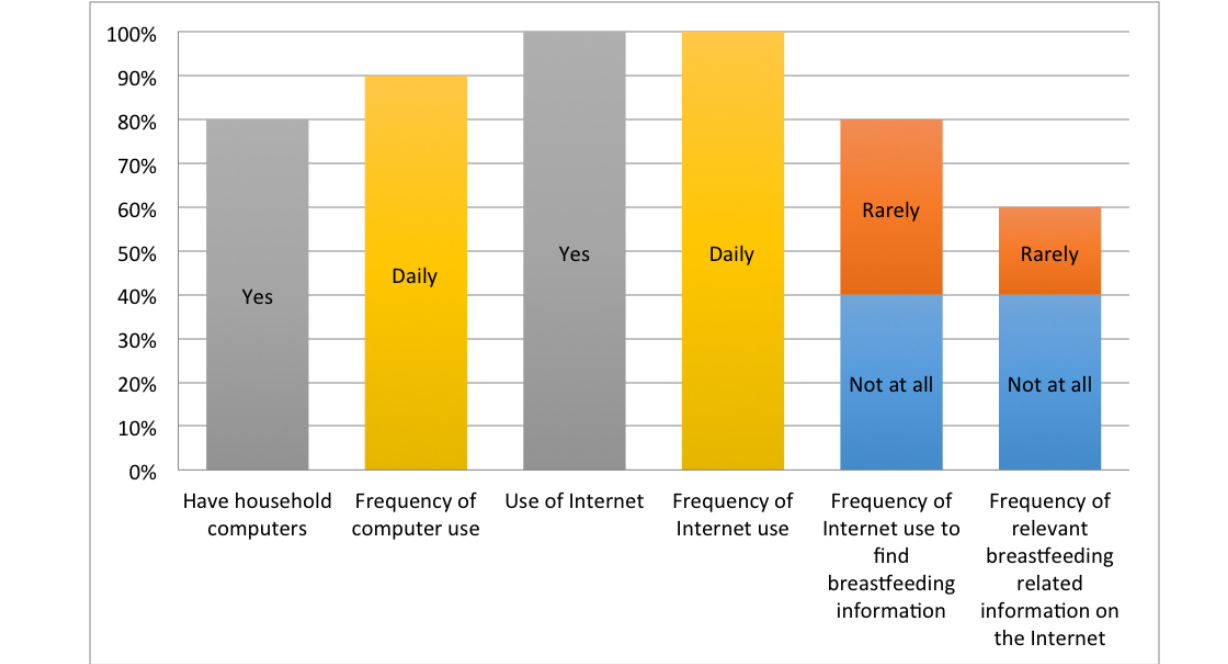
Figure 3. Familiarity with the use of technology and breastfeeding information.